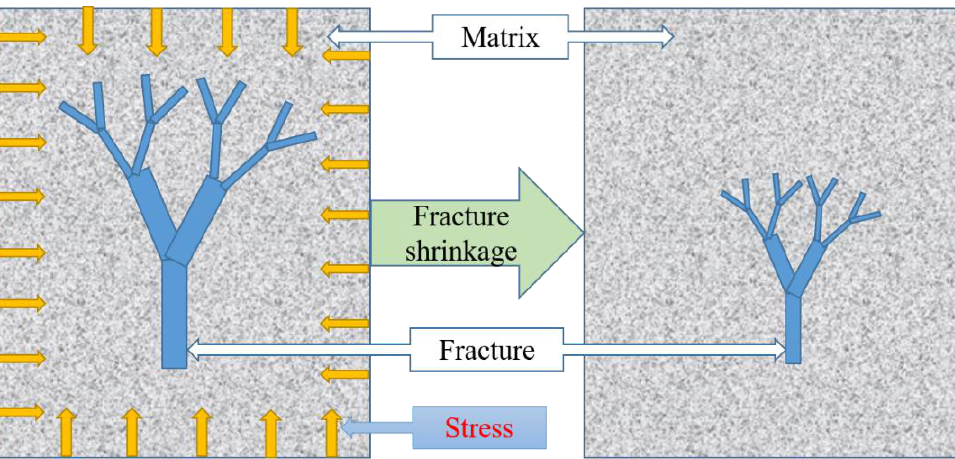
Figure 6. Diagram of strong stress sensitivity characteristics of fractures.